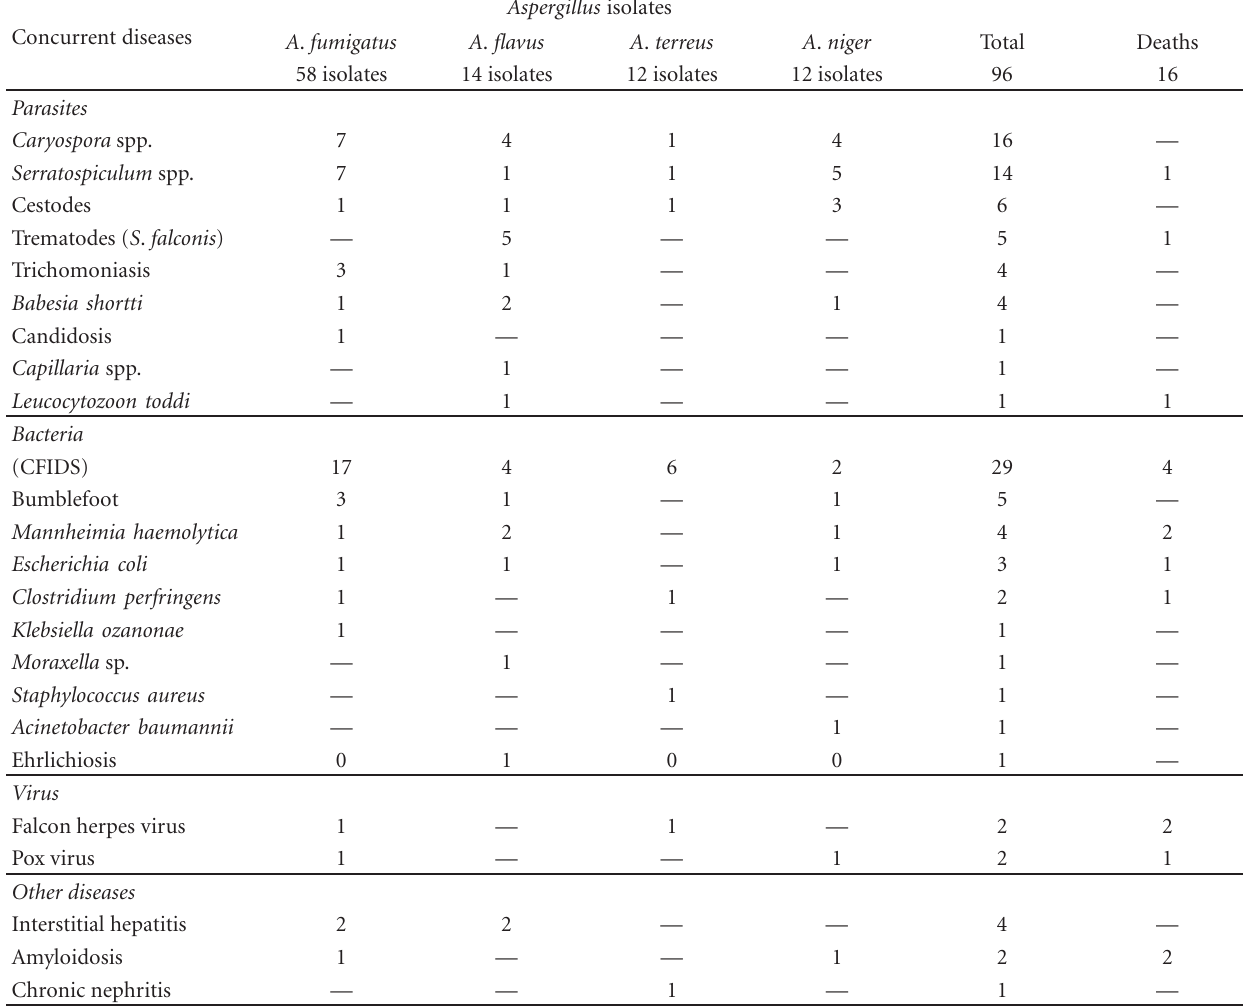
Table 1: Etiologic agents and diseases found associated with aspergillosis in